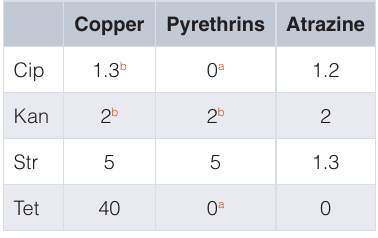
Figure 2. Dose response curves for E. coli BW25113. Antibiotic concentrations used (in µg/mL) were as follows: Tet: 10 µg/mL for copper; Str: 2 µg/mL for copper and 10 µg/mL for pyrethrins. Values are means of at least 3 independent experiments; error bars are standard errors (SEM, with SEM=standard deviation/ √ n). Asterisks indicate the lowest biocide concentration for which a statistically significant change in EoP by at least 100-fold compared to the antibiotic only occurred. * P <0.05; ** P <0.01; *** P <0.001; ns, not